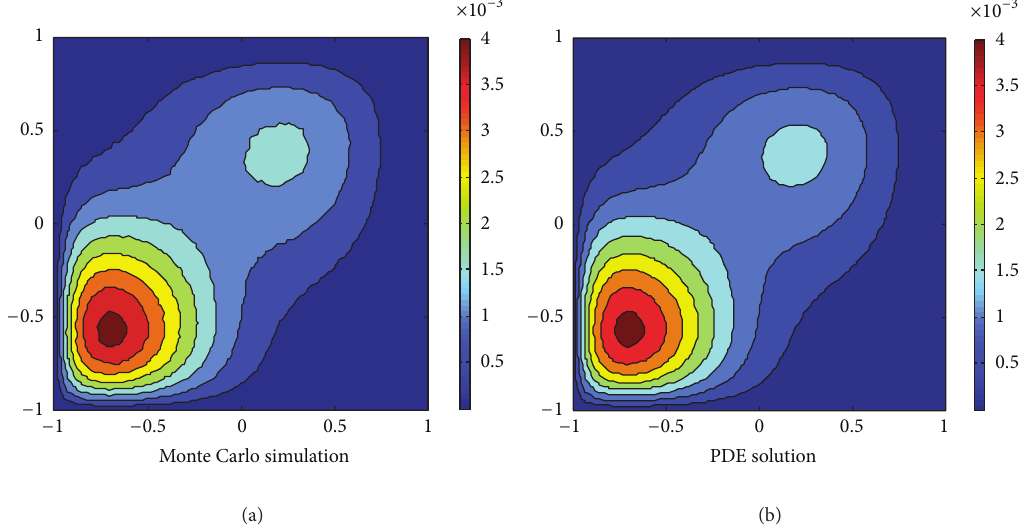
Figure 6: The Monte Carlo simulation and the PDE solution of a 2D 1-step network of Type II communicating neighbors.